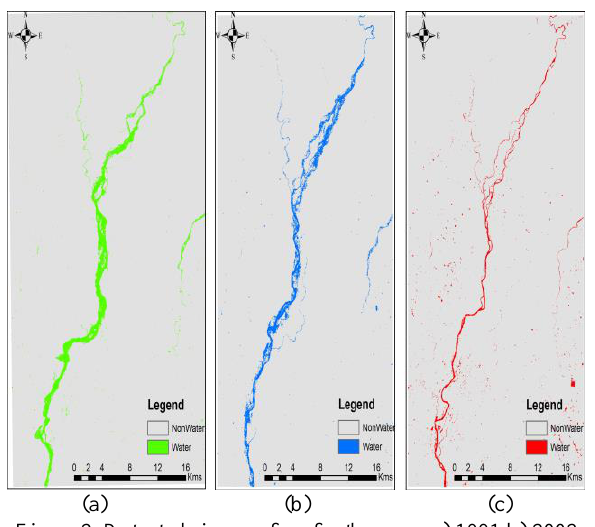
Figure 2. Detected river surface for the years a) 1991 b) 2002